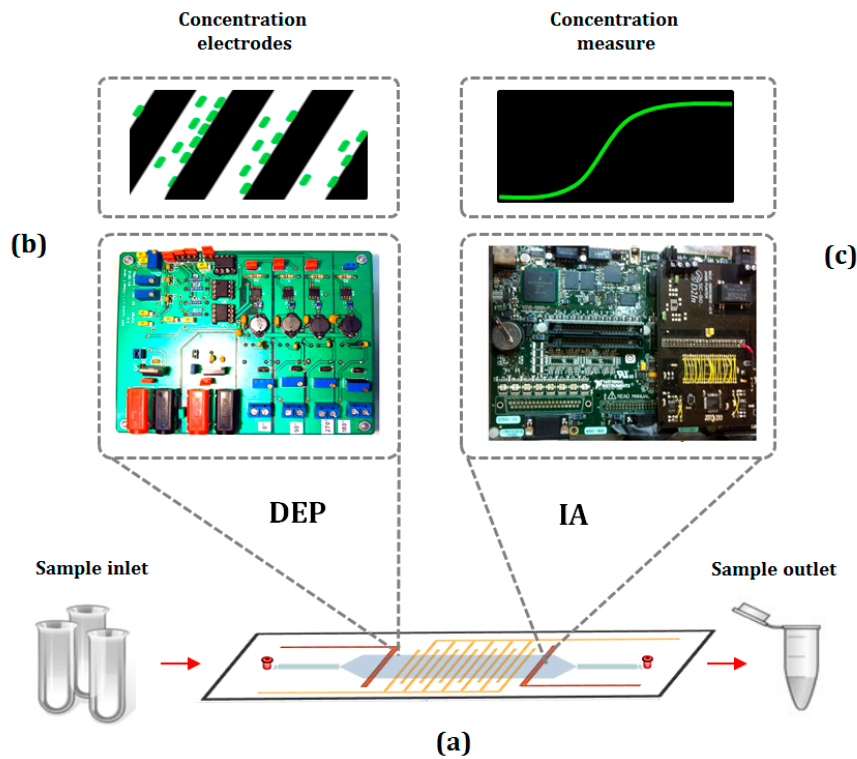
Figure 3. Scheme of the overall process. ( a ) The electronic module; ( b ) Bacteria concentration by dielectrophoresis; ( c ) Concentration measure by impedance analysis (adapted from [36]).